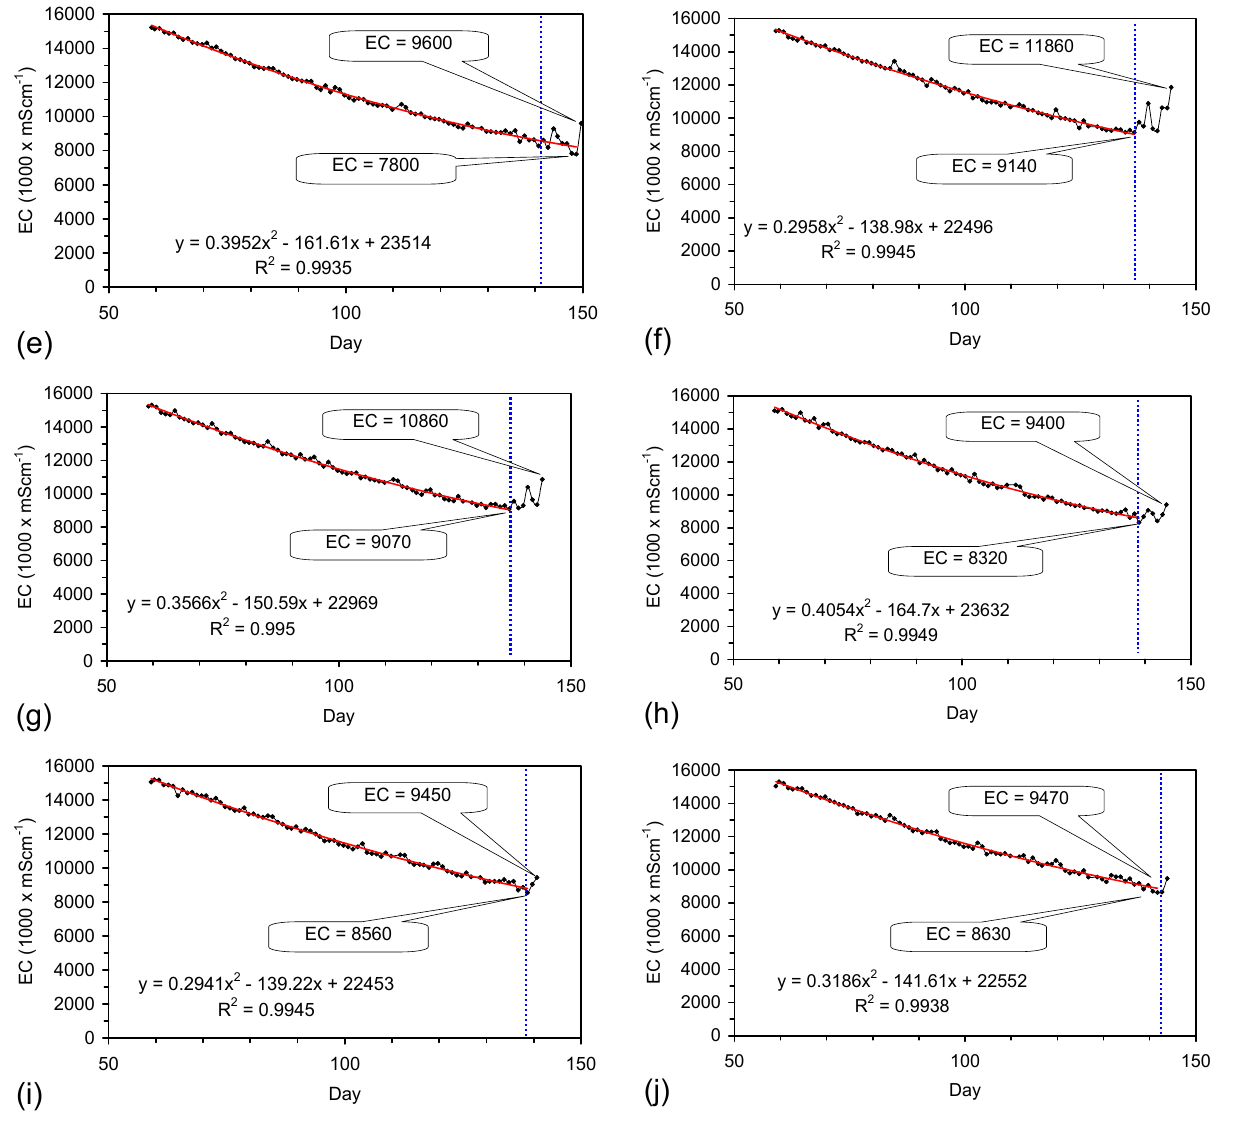
Figure D2. Feed Water EC = 15.200 mS·cm − 1 . ( a ) S1:T1; D = 0.0087; R 2 =